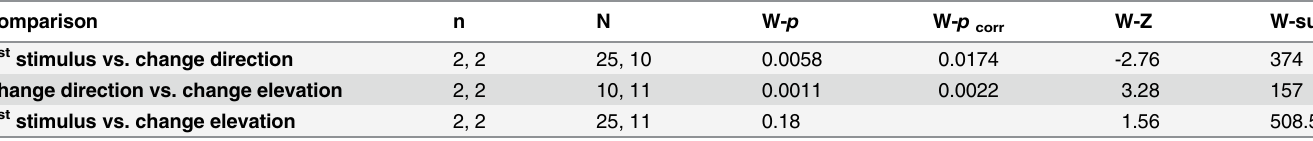
Table 2. Statistics of data distributions shown in Fig 4B. comparison change direction vs. change